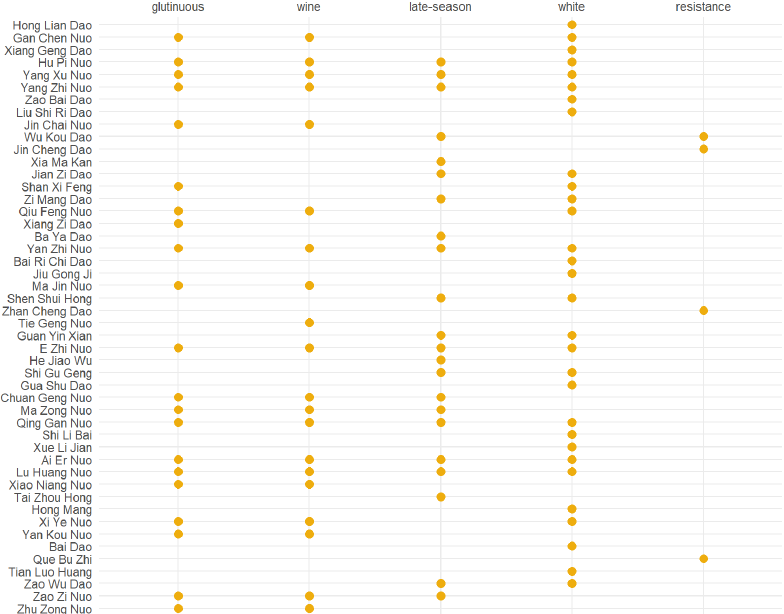
Figure 3. An example of rice features we manually annotate for each cultivar in the dataset. Each yellow dot shows that a certain cultivar contains a specific